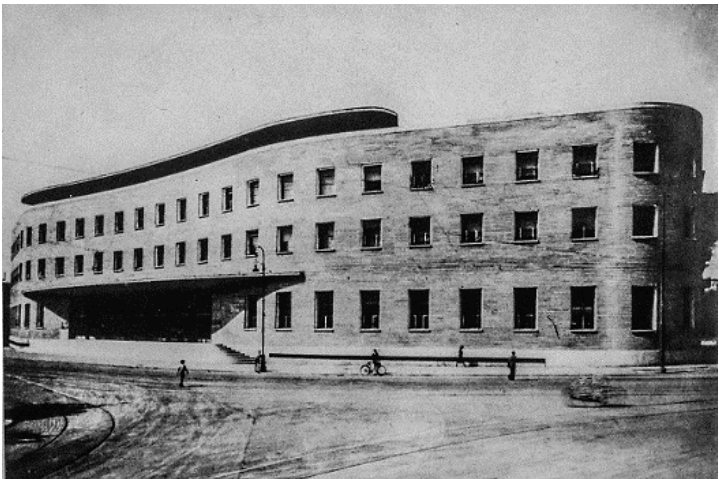
Figure 12. Post Office building by Mario Ridolfi. Rome (1933–1935). Photo from (Poretti 1990, p. 88. Source: Museo storico delle poste e telecomunicazioni).